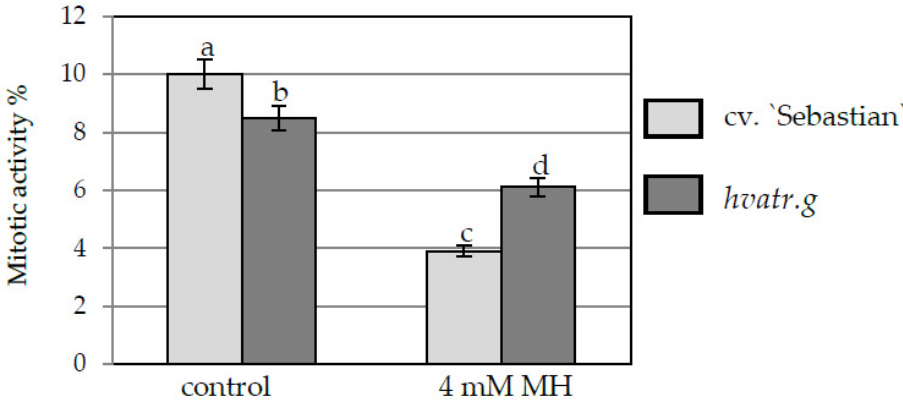
Figure 2. Mitotic activity of root cells of barley seedlings of the hvatr.g mutant and cv. “Sebastian”, control and MH-treated. Error bars represent the standard deviations of the mean. Statistical analyses were performed using ANOVA ( p < 0.05) followed by Tukey’s honestly significant difference test (Tukey HSD test, p < 0.05). Statistically significant differences are indicated by different letters.